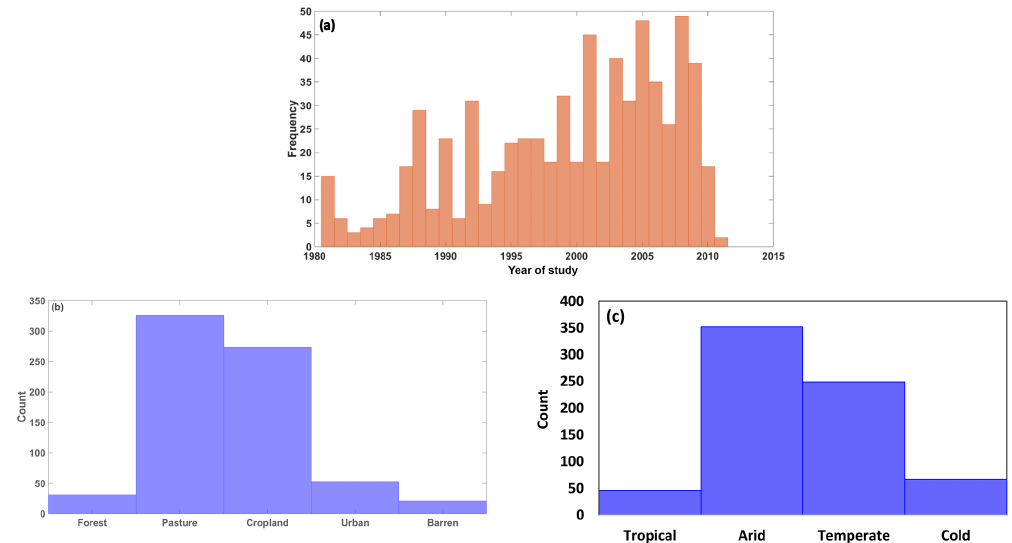
Figure 2. Histograms showing frequency of (a) study year, (b) land use and (c) Köppen–Geiger climate zones for the recharge estimates